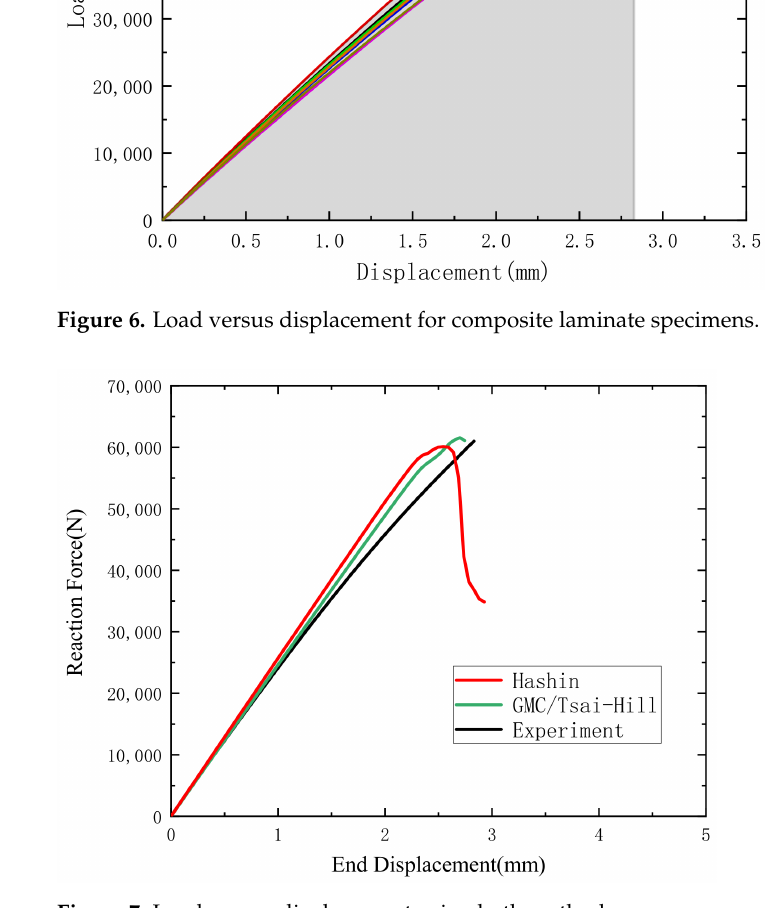
Figure 7. Load versus displacement using both